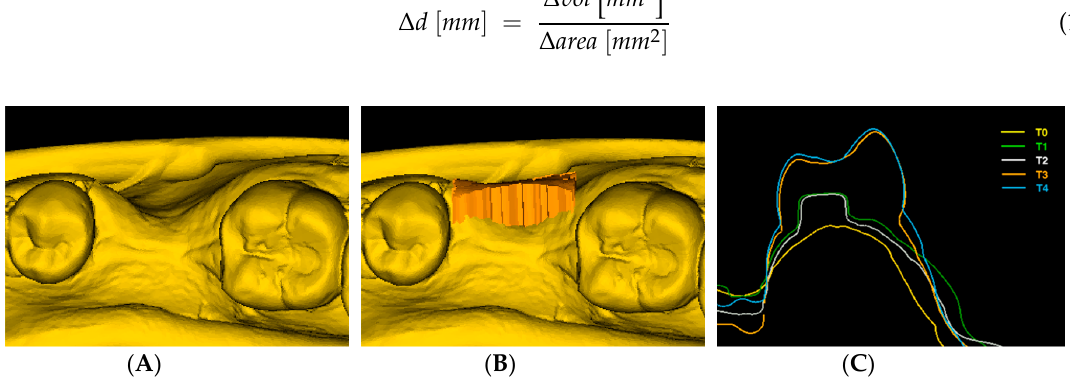
Figure 3. ( A ) Occlusal view of the digital surface model at T0 showing a Seibert Class I defect; ( B ) T0 digital surface model with volumetric changes in the area of interest between T0 and T4; ( C ) Cross- section through the superimposed digital surface models in the center of the grafted area at the different time points.